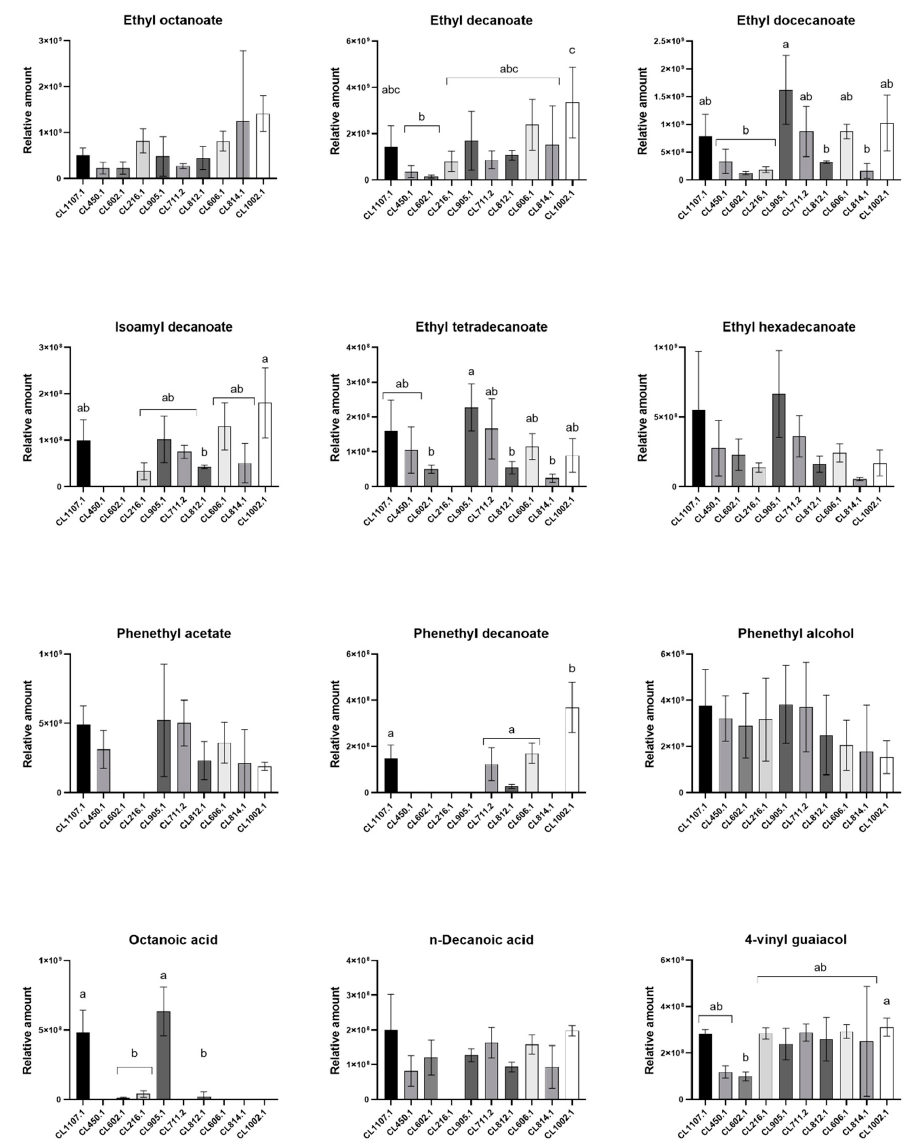
Figure 3. Relative amounts of the main volatile compounds in fermented wort at 12 °C. The strains are distributed according to their fermentative capacity from high to low levels (left to right). Different letters reflect statistically significant differences between strains with a p -value < 0.001, one-way ANOVA. No-letters strains do not show statistically significant differences.